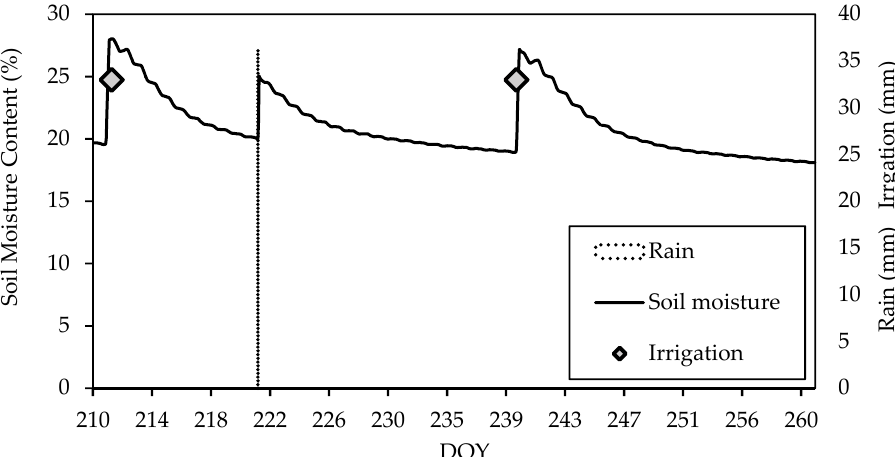
Figure 2. Soil moisture content (%) fluctuation, with irrigation amounts and rainfall during the experimental period.